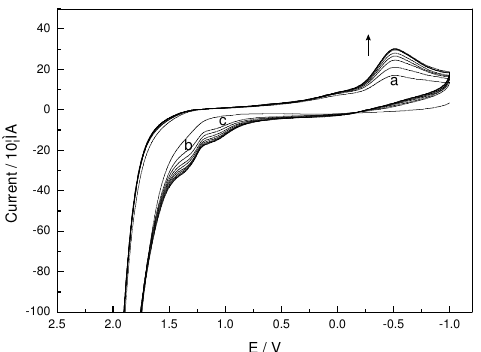
Figure 1. Repetitive cyclic voltammograms of 1.0×10 -4 mol dm -3 acridine red in pH 7.4 PBS solution; Terminal potential: +2.5 V; Initial potential: –1.0 V; Sensitivity: 1.0×10 -4 A/V; Scan rate: 100